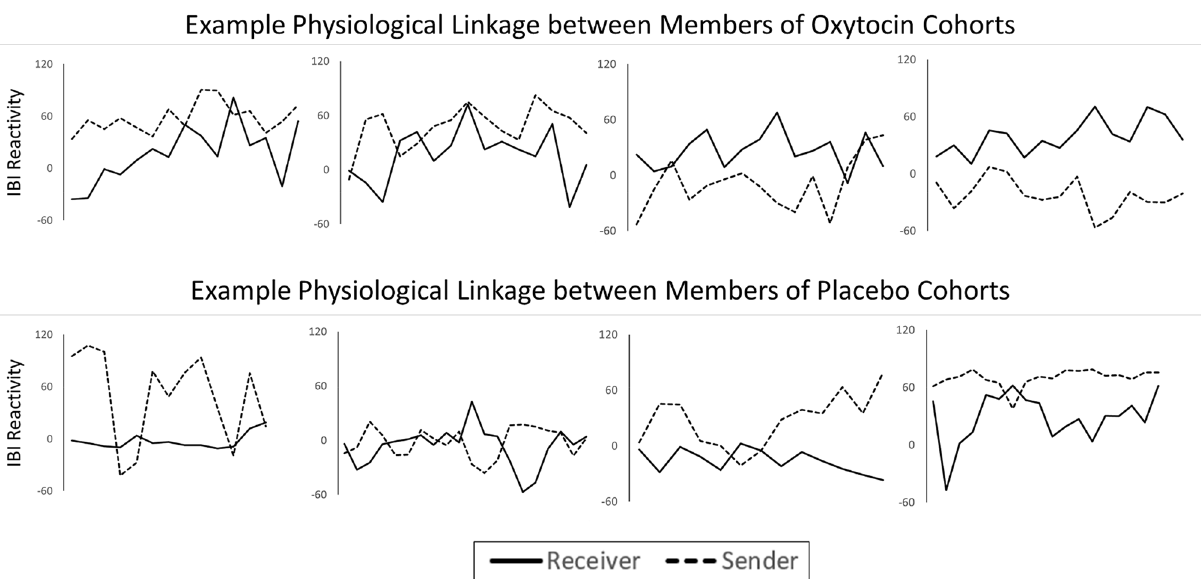
Figure 6. Example IBI reactivity patterns in oxytocin and placebo cohorts. Linkage occurs when the sender’s IBI reactivity predicts the receiver’s IBI reactivity at the next time